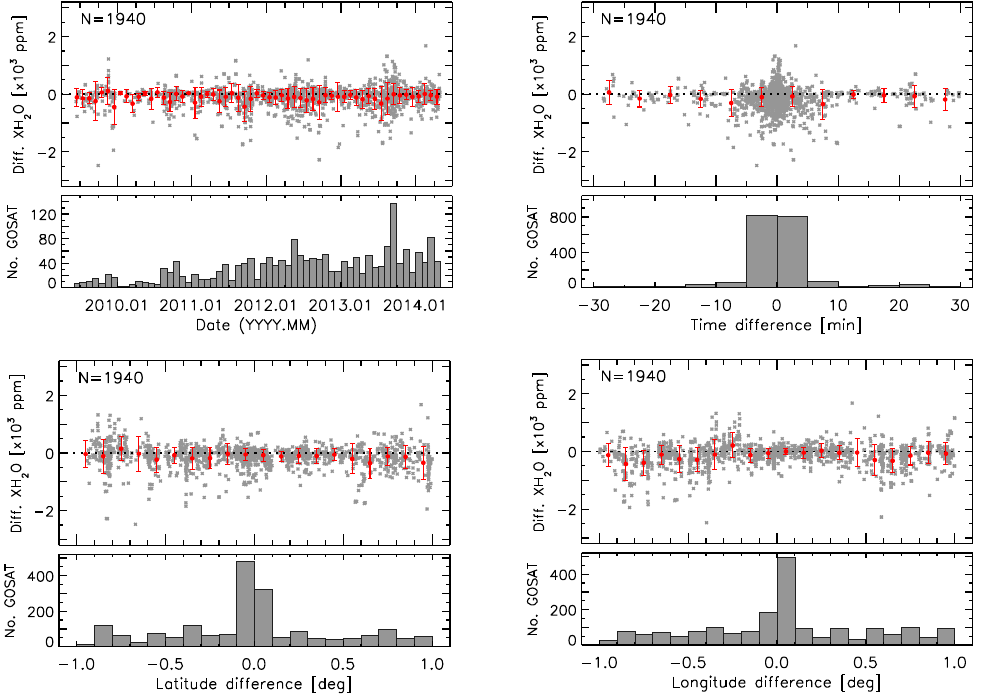
Figure 8. Evolution of the XH 2 O absolute differences (GOSAT − TCCON) for the nominal coincidence criteria ( ± 1 ◦ latitude/longitude and ± 30min) as a function of the measurement date (time series, top left panel) and of the collocation characteristics: time, latitude and longitude differences (top right, bottom left and bottom right panels, respectively). The corresponding histograms of the number of TANSO-FTS scans are plotted below each panel. The grey dots represent the single-scan differences; the red symbols with “error bars” show the average value and associated standard deviation within each histogram bin.